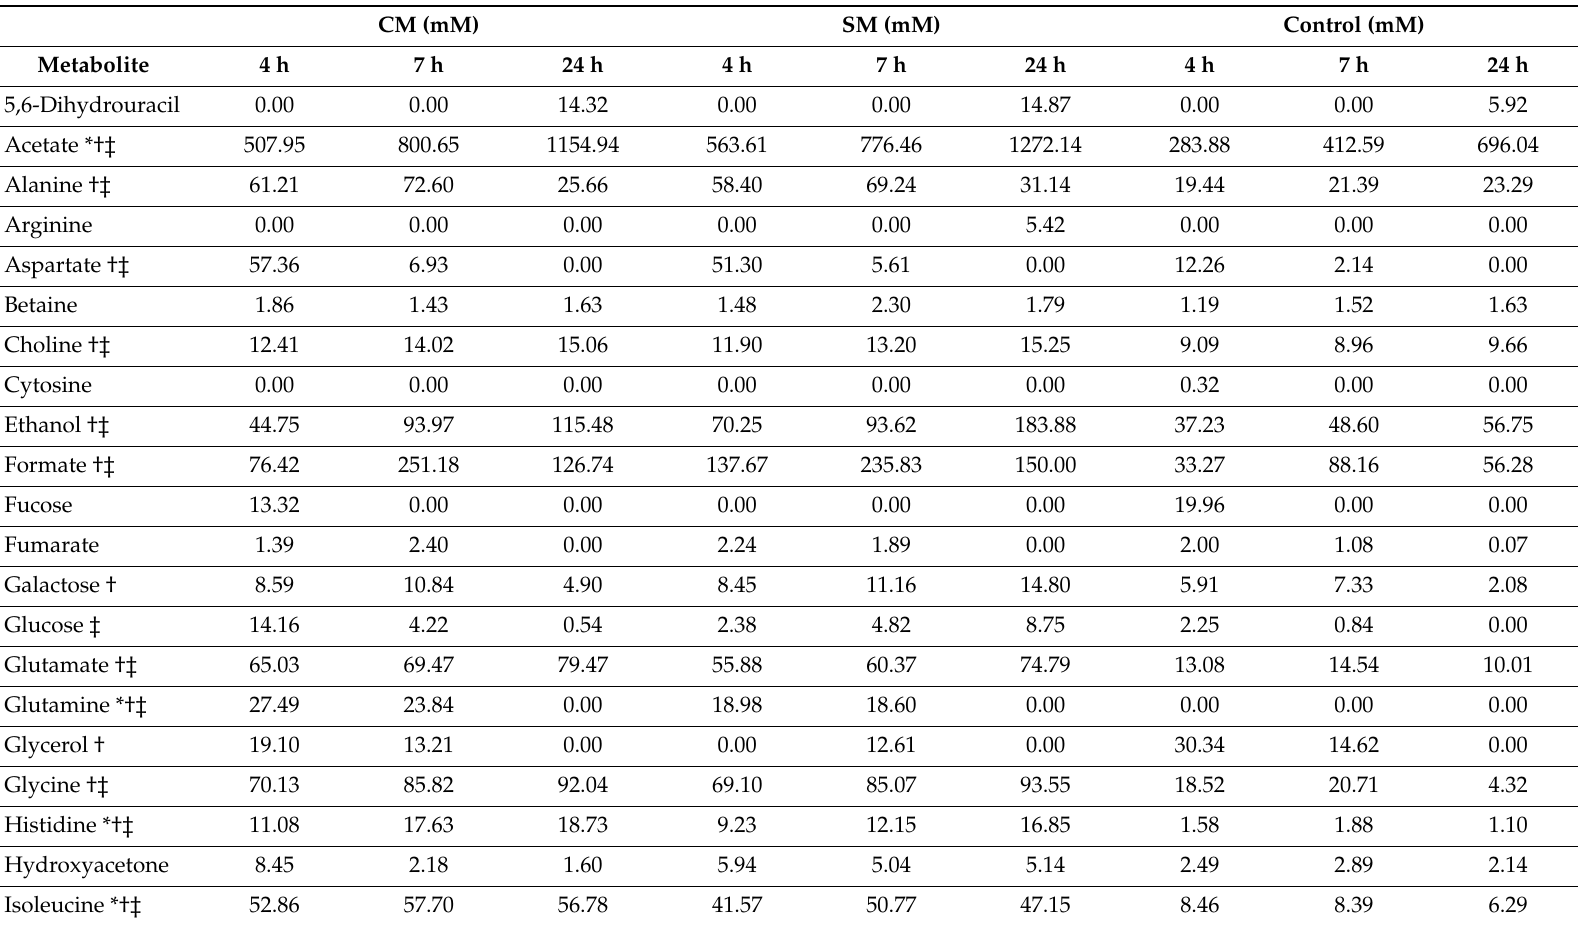
Table A5. Concentrations of metabolites detected by NMR in five-month-old fecal